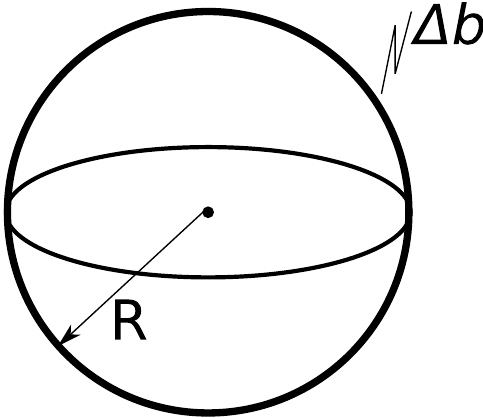
Figure 1. Schematic view of the addressed mechanical